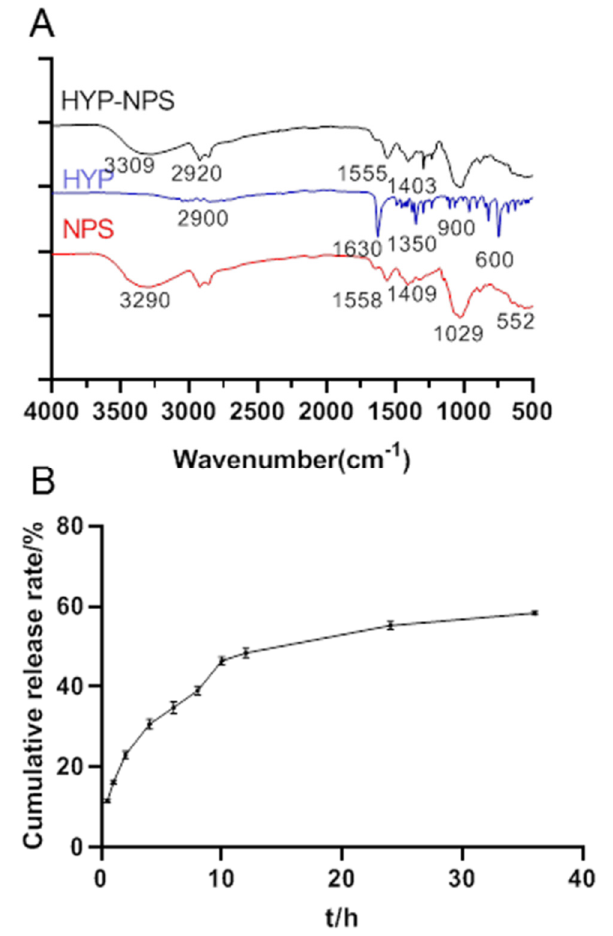
Figure 2. ( A ) The FT-IR spectra of HYP-NPS nanoparticles. ( B ) Sustained release curves of HYP from HYP-NPS solution ( n = 3).